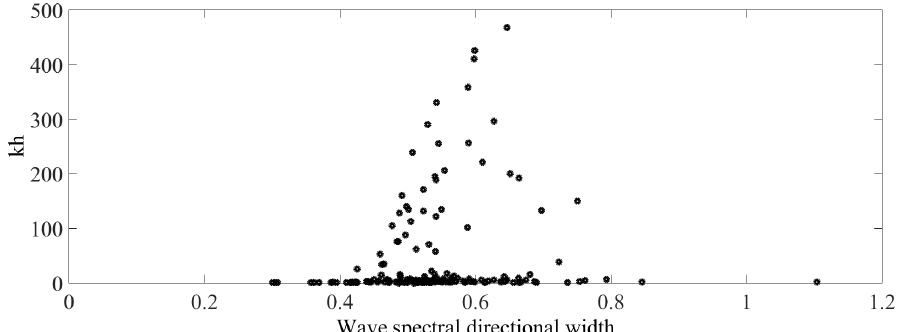
Figure 11. Wave spectral directional width versus the parameter kh for deep and shallow